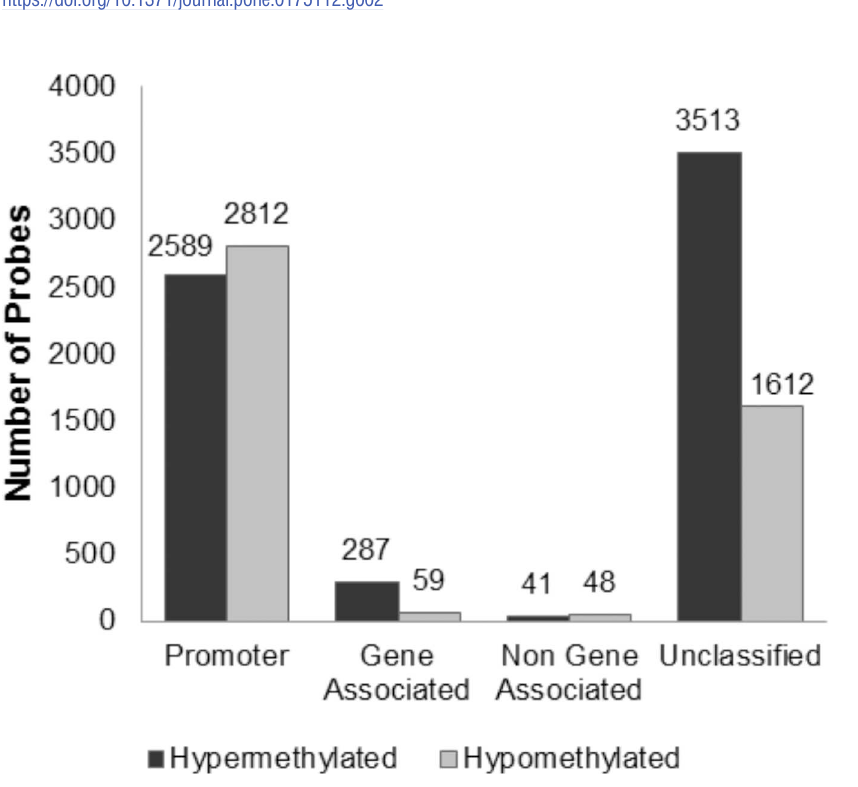
Fig 3. Number of differentially methylated probes between FECD and control samples (P < 0.05), grouped by the targeted genomic regions.